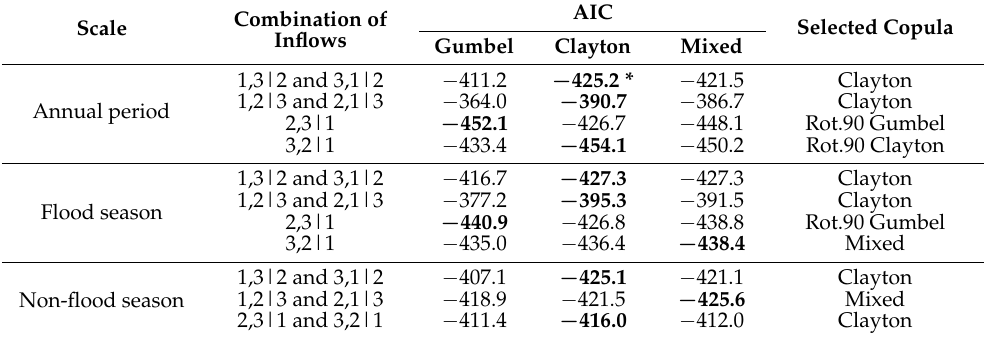
Table 8. The AIC values and selected conditional copula functions between each two inflows. Scale